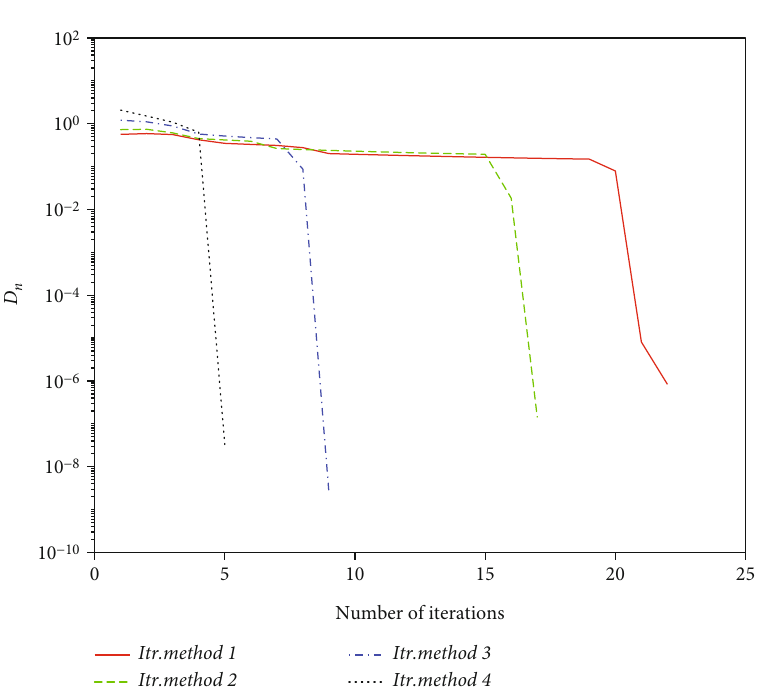
= ð 2, 3, 2, 5, 2 Þ T 0